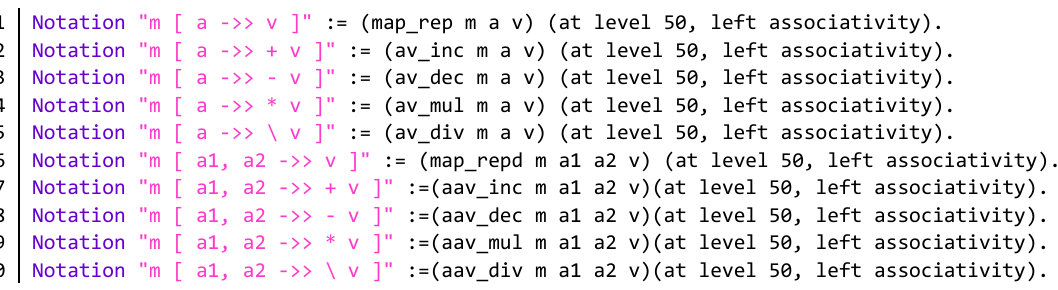
Figure 7. Notations of safe operators on